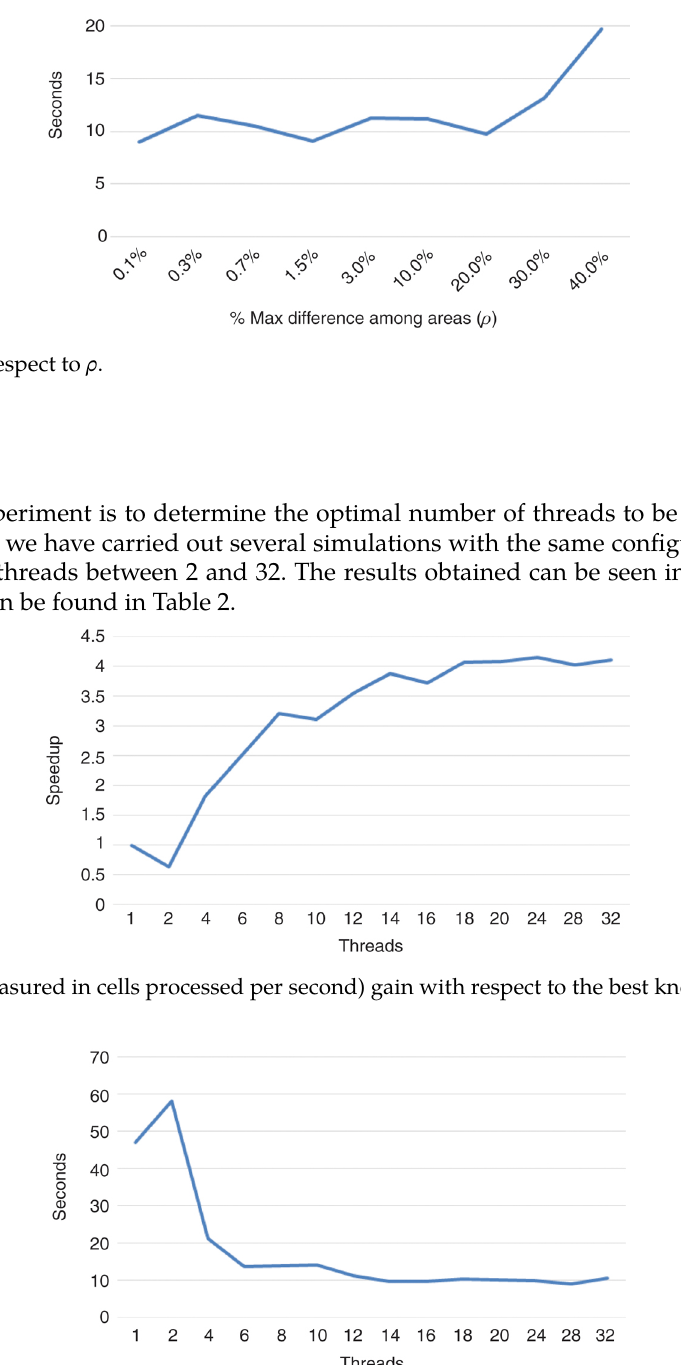
Table 2: Simulation performance with respect to the number of threads ( ρ = 0.01). The single thread simulation corre- sponds to the sequential implementation proposed in [2]. Speedup is calculated with respect to the number of cells pro- cessed per